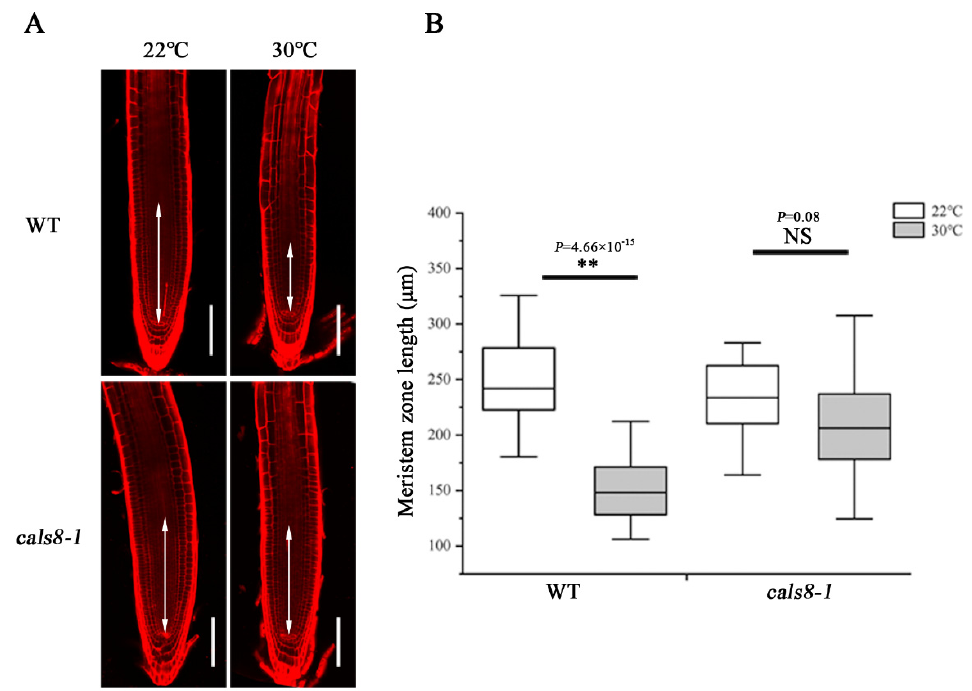
Figure 5. Loss of CalS8 rescues the decrease in meristem size under heat stress. ( A ) Five-day-old roots of WT and cals8-1 were transferred to 22 °C and 30 °C for 48 h and stained with propidium iodide to visualize the cell walls. Double arrows indicate the meristem zone. Scale bars = 100 μ m. ( B ) Quantification of the meristem length in A, n > 20. In the box plots, the boxes indicate the first and third quartiles, and the whiskers indicate the minimum and maximum values. The black lines within the boxes indicate the median values. ** p < 0.01 (two-tailed, two-sample t -test). NS, not significant.